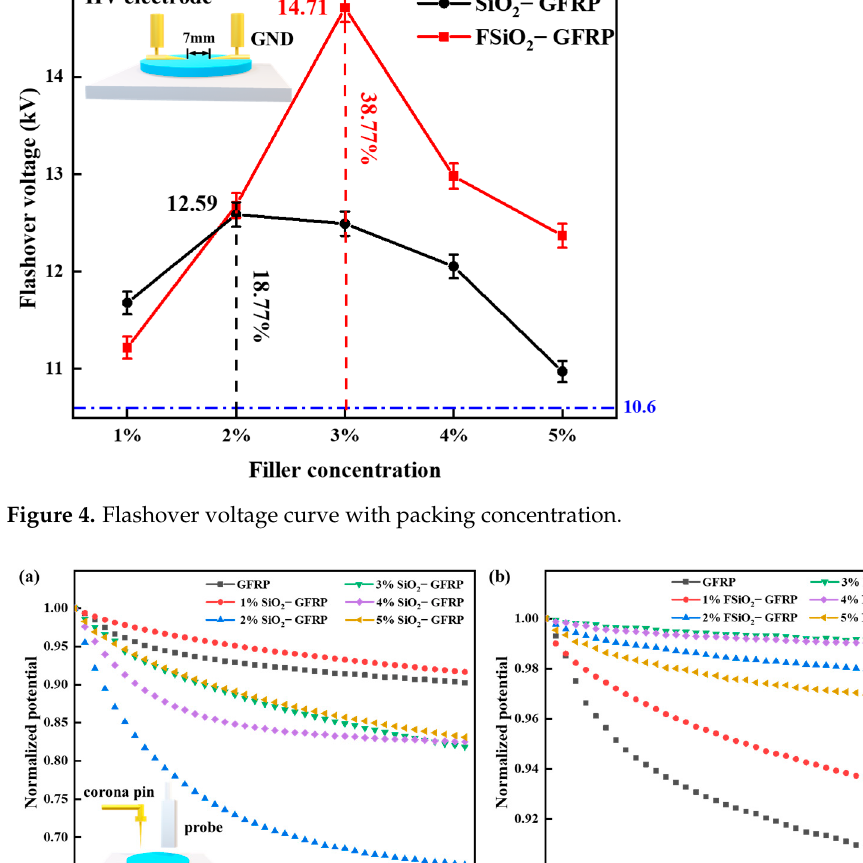
2 -GFRP. ( b ) FSiO 2